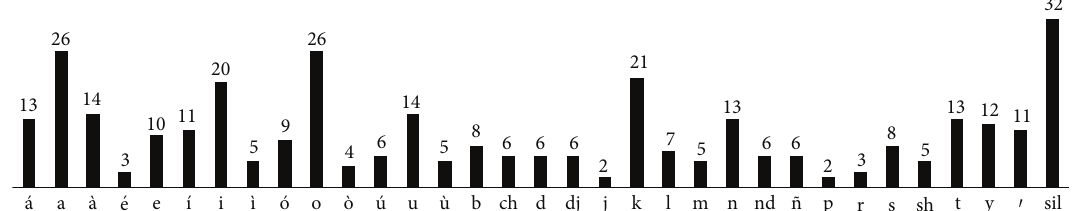
Figure 8: Frequency distribution of phonemes in the Mixtec adaptation stimuli.